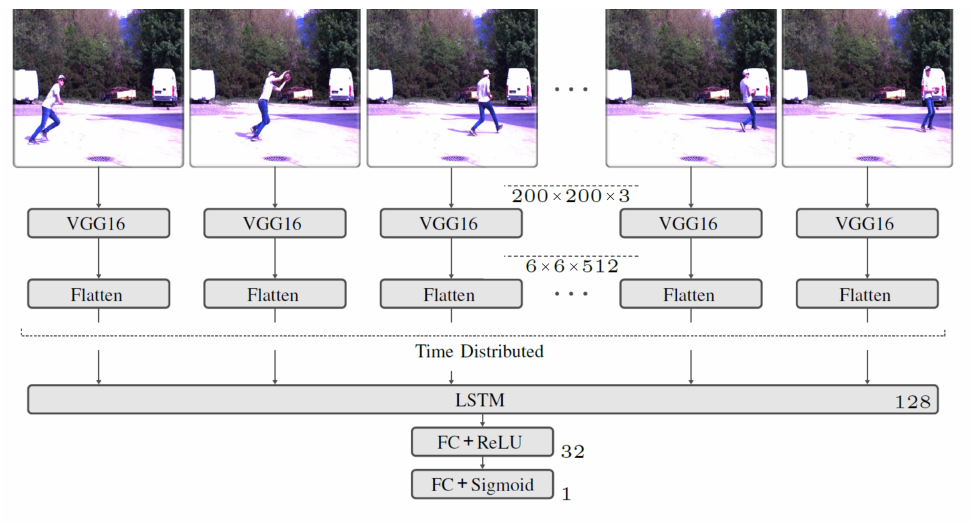
Figure 4. Network structure of the video model with the applied operations. To the right of the operations, their set parameters can be seen, such as the number of neurons, filters and filter sizes. The size of the tensor, at the model input and at the output of the VGG16 network, is shown in the